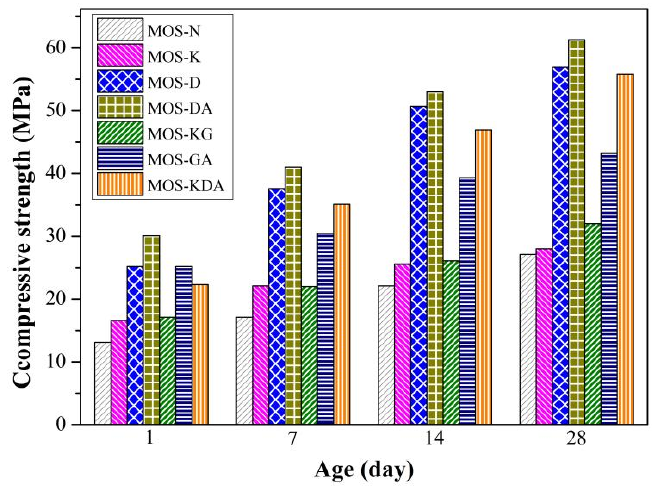
Figure 3. Compressive strength of magnesium oxysulfate cement with different modifiers.